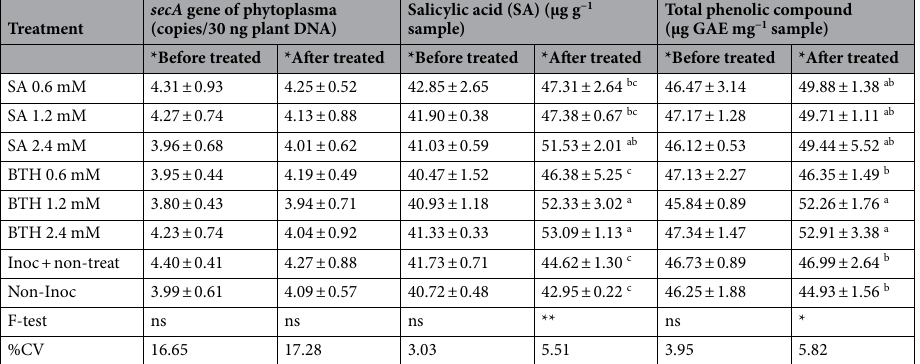
Table 1. Quantification of the gene secA , salicylic acid and total phenolic compound in control groups (inoculated control and non-inoculated control), before (the sampling time 1) and after spraying the elicitors (the sampling time 2) in sugarcane treated groups. *Number of averages in before and after treated (n =